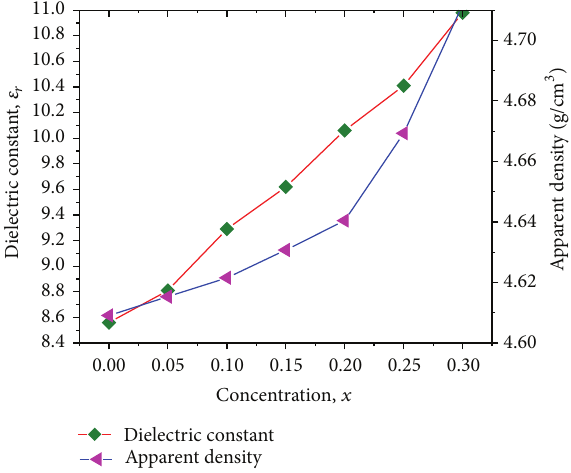
Figure 5: Tauc plot to determine optical bandgap from UV-Vis absorption spectrum.